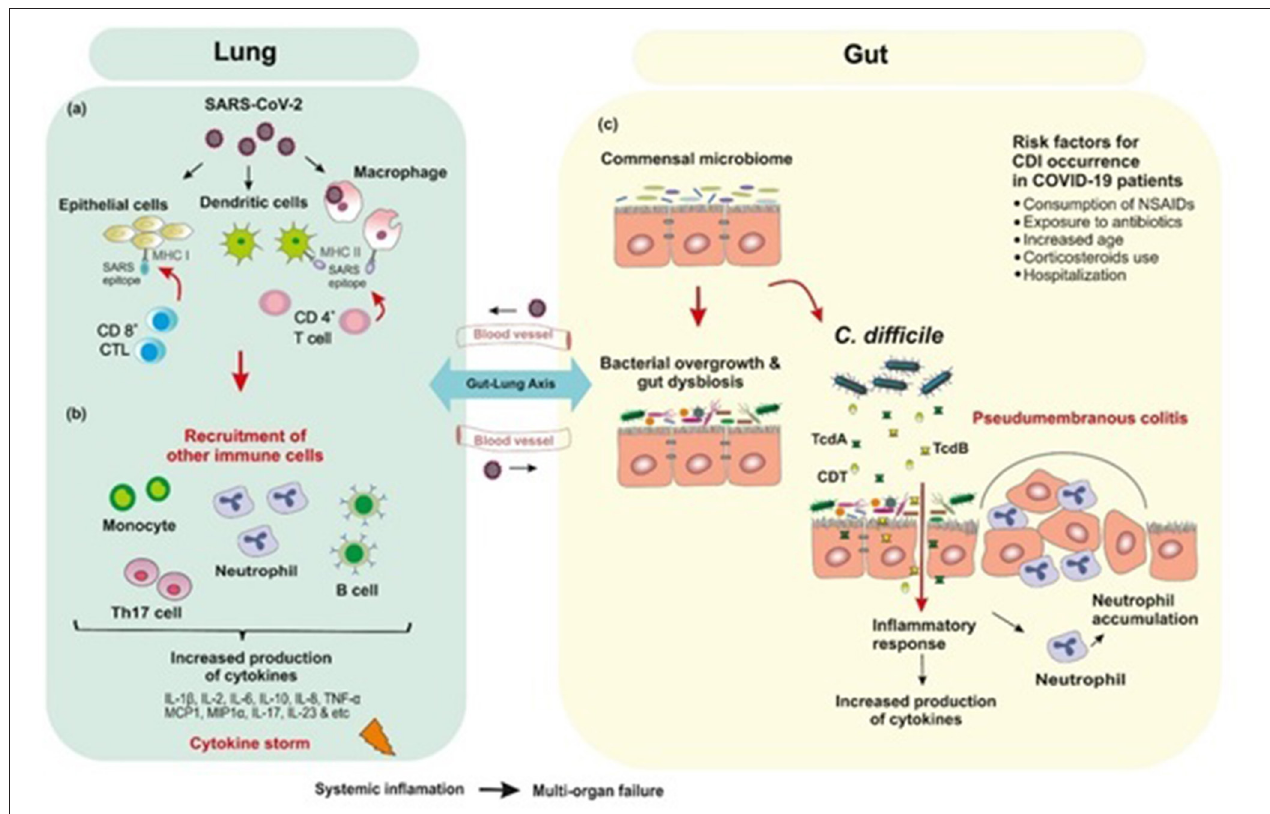
FIGURE 2 | Postulated schematic diagram of the interplay of human gut microbiota and SARS-CoV-2 with bacterial coinfections. (a) SARS-CoV-2 binds to ACE2 receptor which mediates direct binding of virus to the human lungs and evokes an immune response. (b) Inflammation occurs through the immune responses of both innate and adaptive immune system. CD8 + cytotoxic T cells which are able to secret a cluster of molecules are essential in the eradication of virus infected cells. CD4 + helper T cells facilitate the overall adaptive response by assisting cytotoxic T cells. B-cell mediated humoral immune response plays a protective role by producing neutralizing antibodies, and also impedes re-infection. SARS-CoV-2 infection triggers the release of inflammatory cytokines and chemokines, which lead to the recruitment of neutrophils and other immune cells. (c) Empirical antibiotic therapy for bacterial infections in hospitalized COVID-19 patients are associated with depletion of beneficial commensals and enrichment of opportunistic pathogens such as Clostridioides difficile infection. The immune response to C. difficile is similar to that produced against SARS-CoV-2 in which inflammatory cytokines are